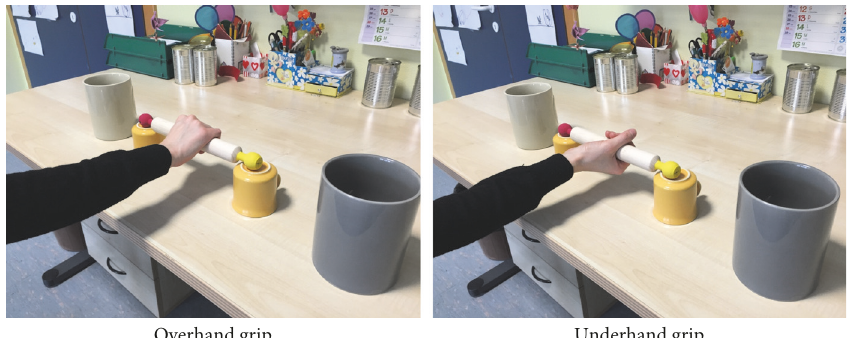
Figure 1: Setup of the Stick Test for evaluating action